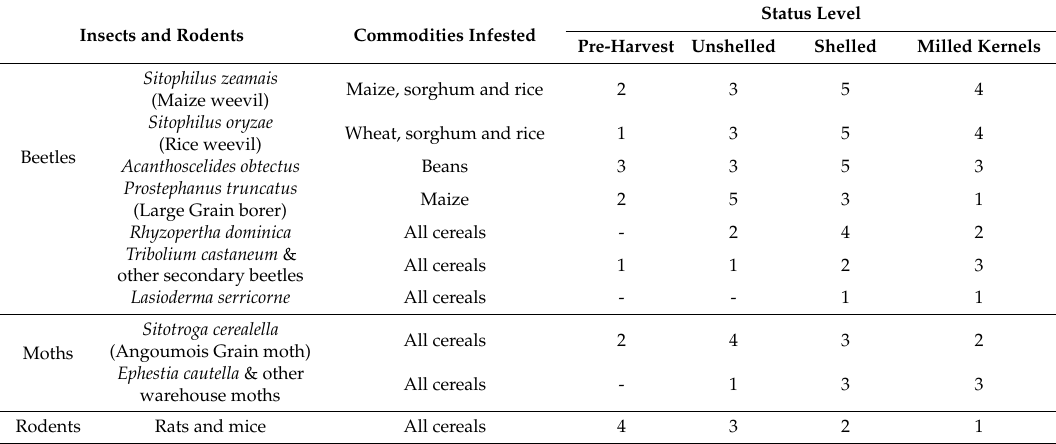
Table 1. Common insects and rodents infesting grain in developing countries